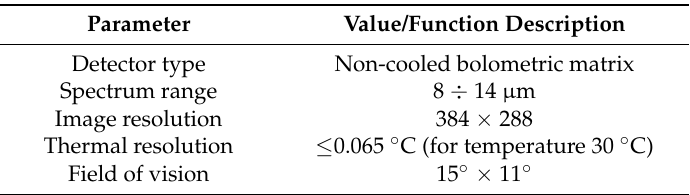
Table 1. Relevant parameters of VIGOcam v.50 camera [10].